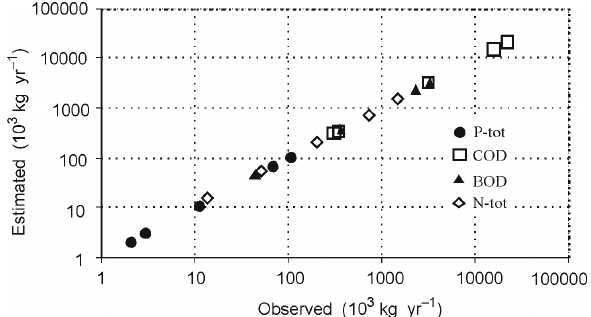
Fig. 3. Observed load of constituents against estimated values (log